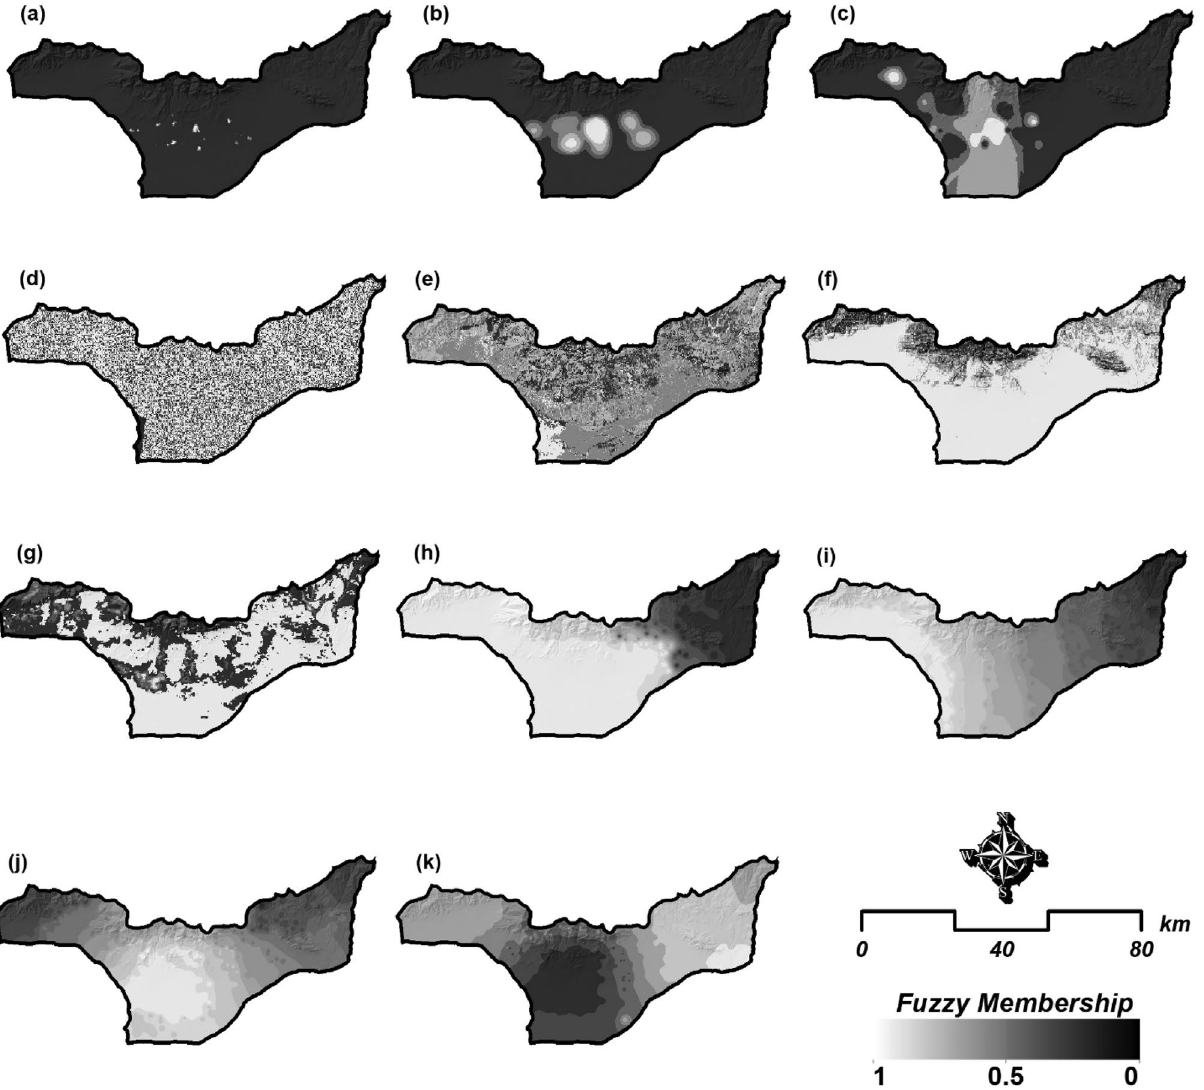
Figure 5. Fuzzy-based standardized layers of the selected criteria shown in Fig. 4 for the vulnerability and health risk mapping: ( a ) age group, ( b ) current status of hypertension, ( c ) population density, ( d ) slope-aspect, ( e ) land use/cover, ( f ) slope, ( g ) vegetation continuous fields, ( h ) moisture, ( i ) distance to salt-center, ( j ) wind speed, and ( k ) wind direction. Note : due to heterogeneous contexts of the indictors, we standardized all criteria in fuzzy scale for the spatial aggregation of HH-VRM. The map is created in ESRI- Arc GIS version 10.7 under licenses of Humboldt-Universität zu Berlin (https:// deskt op. arcgis.